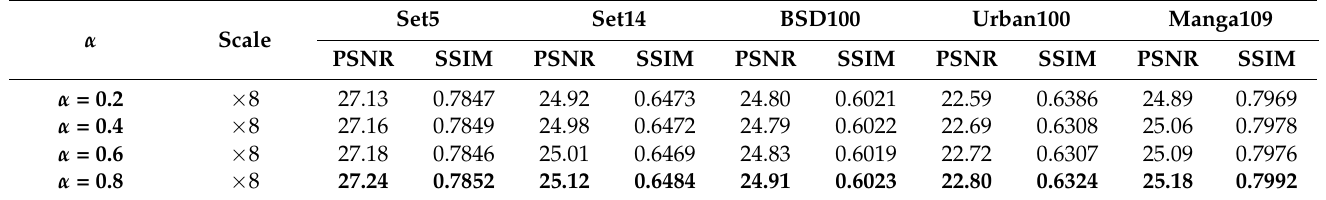
Table 6. Quantitative performance comparison among different objective functions at × 8 scale.